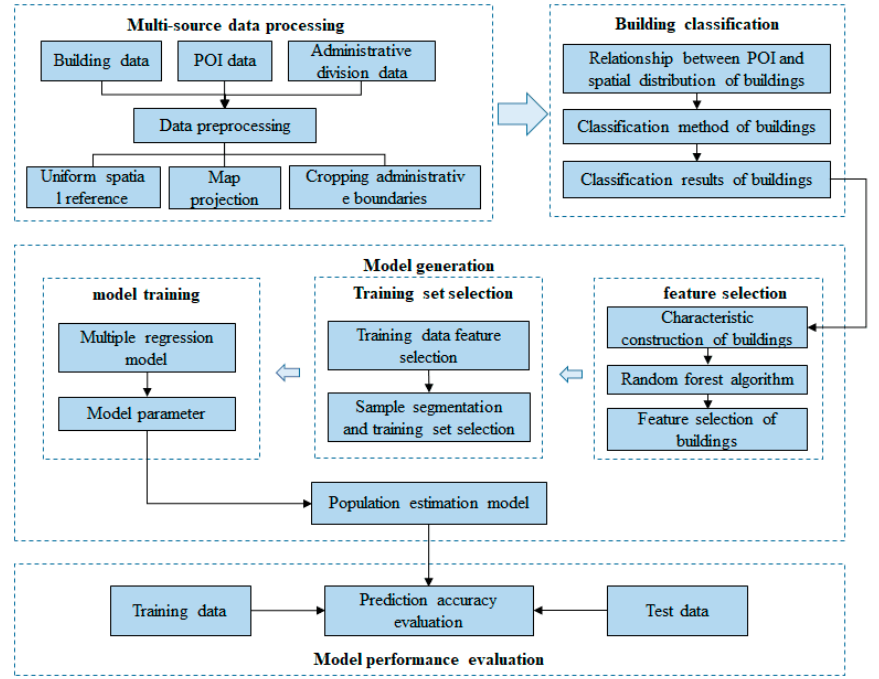
Figure 4. Population estimation method.